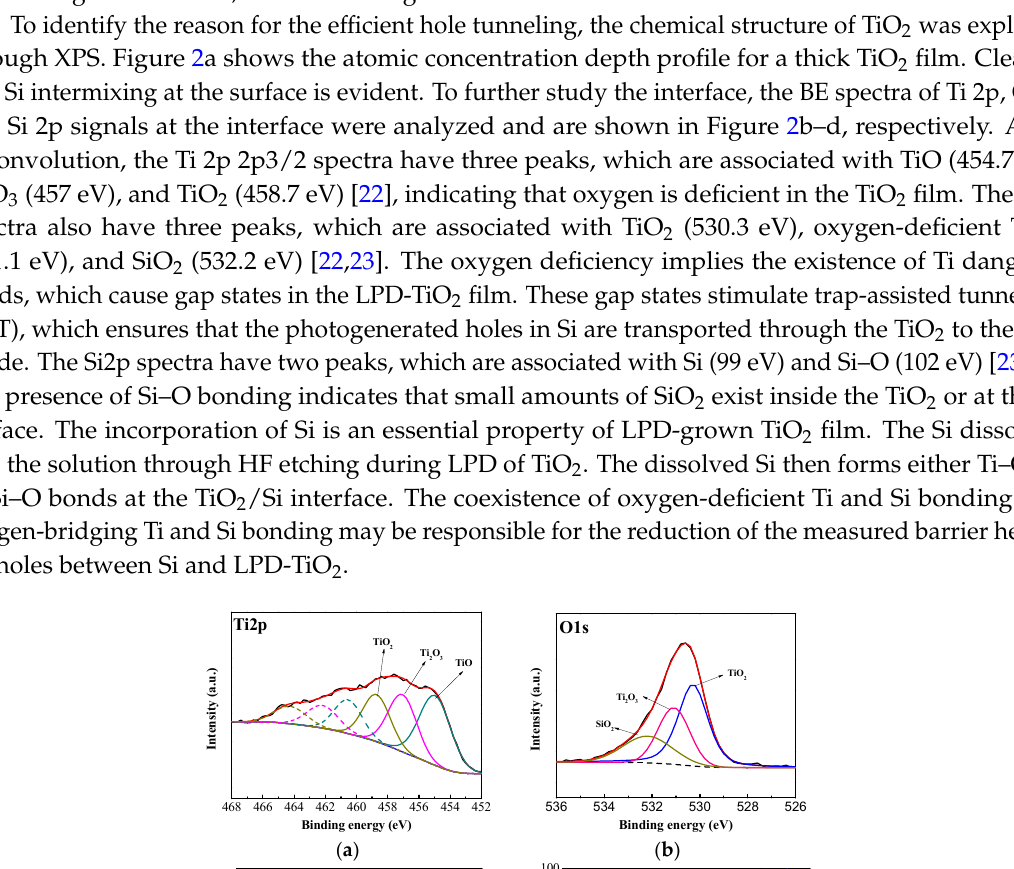
2 obtained through